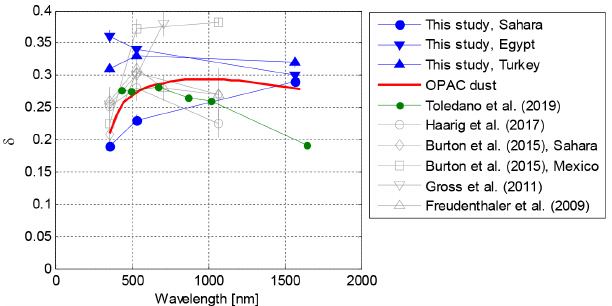
Figure 17. Particle linear depolarization ratio as a function of wave- length for dust observations in Table 2. Additionally, spectral de- pendency modelled with MOPSMAP based on the OPAC database for desert dust (Koepke et al., 2015; Gasteiger and Wiegner, 2018) and AERONET inversion by Toledano et al. (2019) are